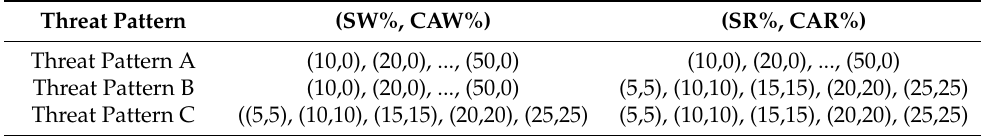
Table 3. Threat patterns and the proportion of malicious